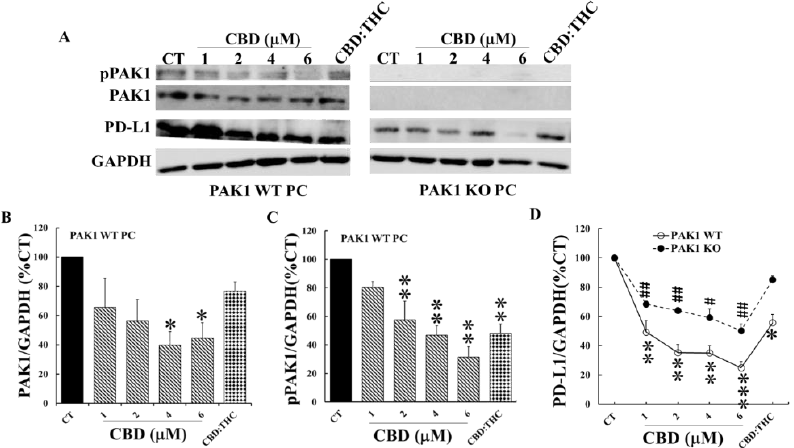
Figure 4. CBD and THC inhibited PD-L1 expression of PC cells by decreasing PAK1 activity. PAK1 wild type (WT) and knockout (KO) murine pancreatic cancer (PC) cells were incubated with CBD or CBD plus THC (1 µM:1 µM) for 24 h. The cells were lysed, and the cell lysates were subjected to Western blotting with antibodies against total PAK1, active phosphorylated PAK1 (pPAK1), PD-L1 and GAPDH. Two representative blots were shown in ( A ). The relative expression levels of PAK1 ( B ), pPAK1 ( C ) and PD-L1 ( D ) were calculated from three independent sets of experiments while the values obtained from the non-treated controls of PAK1 WT cells were taken as 100%. In ( D ), the non-treated controls for either PAK1 WT or KO were taken as 100% for the treated WT and KO cell line respectively. CT: control. *, p < 0.05; **, p < 0.01, ***, p < 0.001 compared to the values obtained from the non-treated controls of PAK1 WT cells. #, p < 0.05; ##, p < 0.01 compared to the values from the non-treated controls of PAK1 KO cells ( D